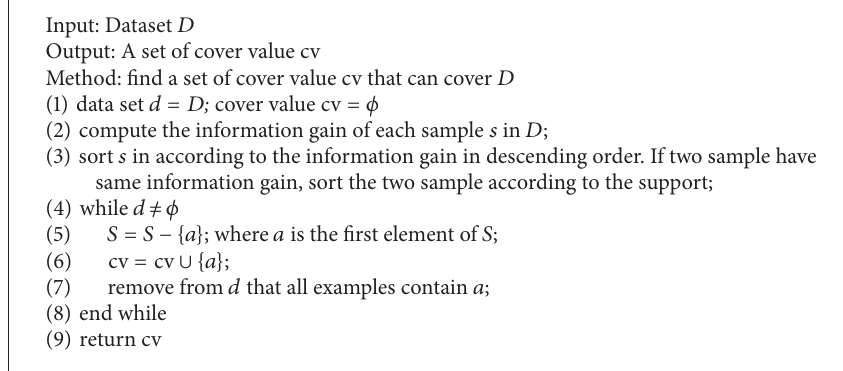
Algorithm 2: Finding covered values in dataset.